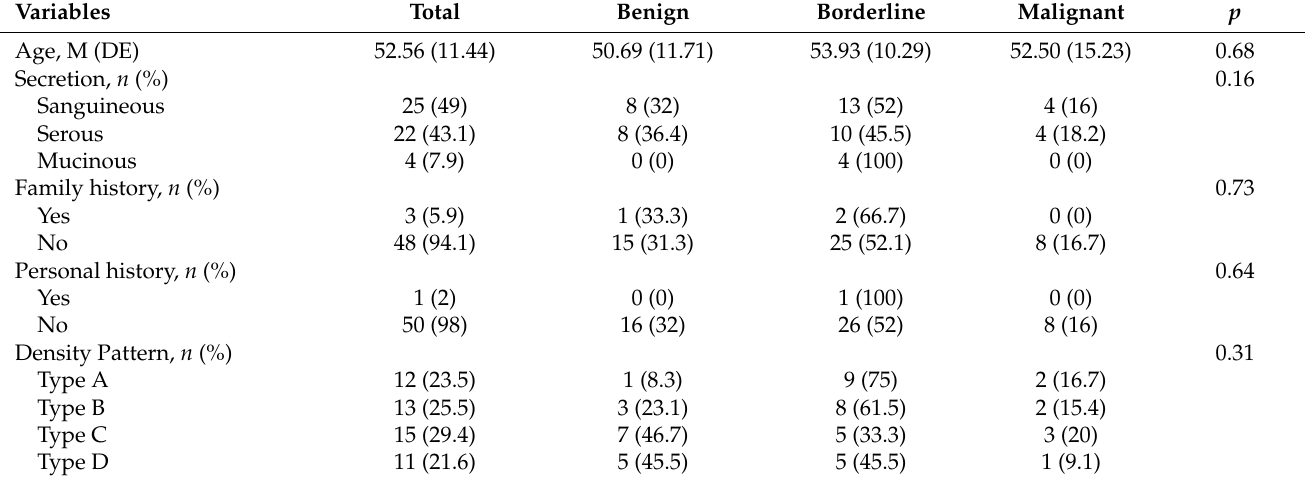
Figure 3. Flow diagram of the patients in this study. Table 1. Demographic and clinical characteristics.